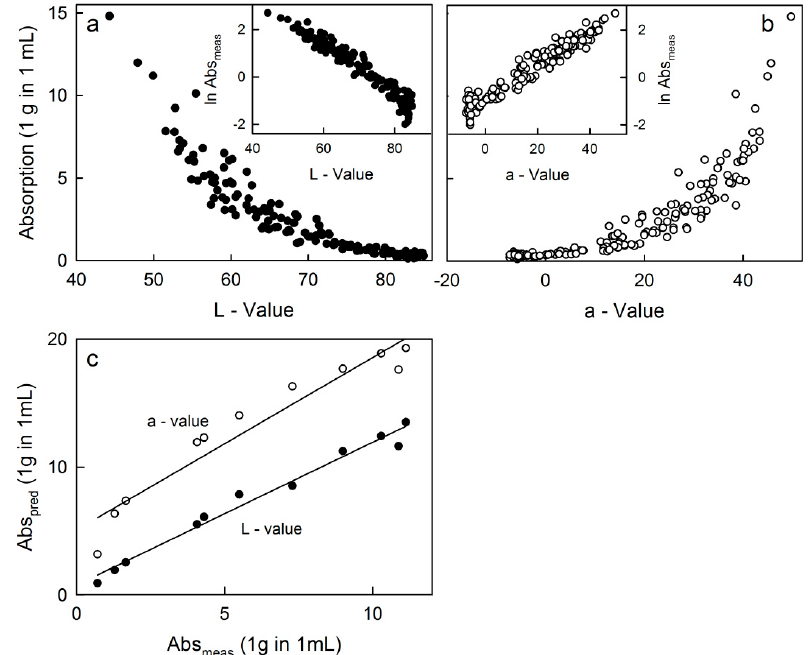
Figure 2c. The absorption predicted from L-values was closely and linearly related to the measured absorption (slope 1.12 ± 0.05, r 2 = 0.98 ***). The intercept did not differ significantly from zero and hence, the regression line was forced through the origin. Relationships with the a-value were inferior, due to an overestimation of the predicted absorption (slope 1.35 ± 0.13), systematic deviations for medium a-values (r 2 = 0.93 ***).